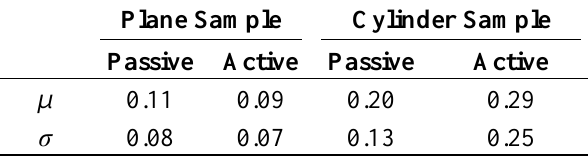
Table 5. Accuracy evaluation on a planar and cylindrical sample in clear water (mm) .